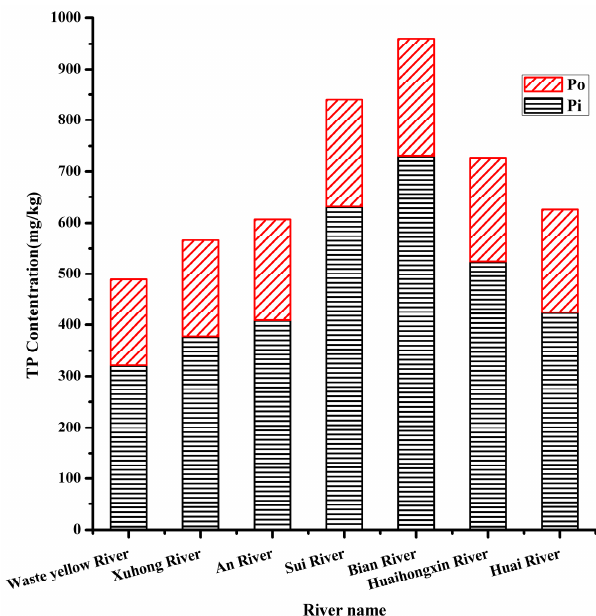
Figure 3. Concentrations of P fractions in the sediments of the seven rivers. Organic phosphorus (Po), inorganic phosphorus; (Pi), phosphorus (P).